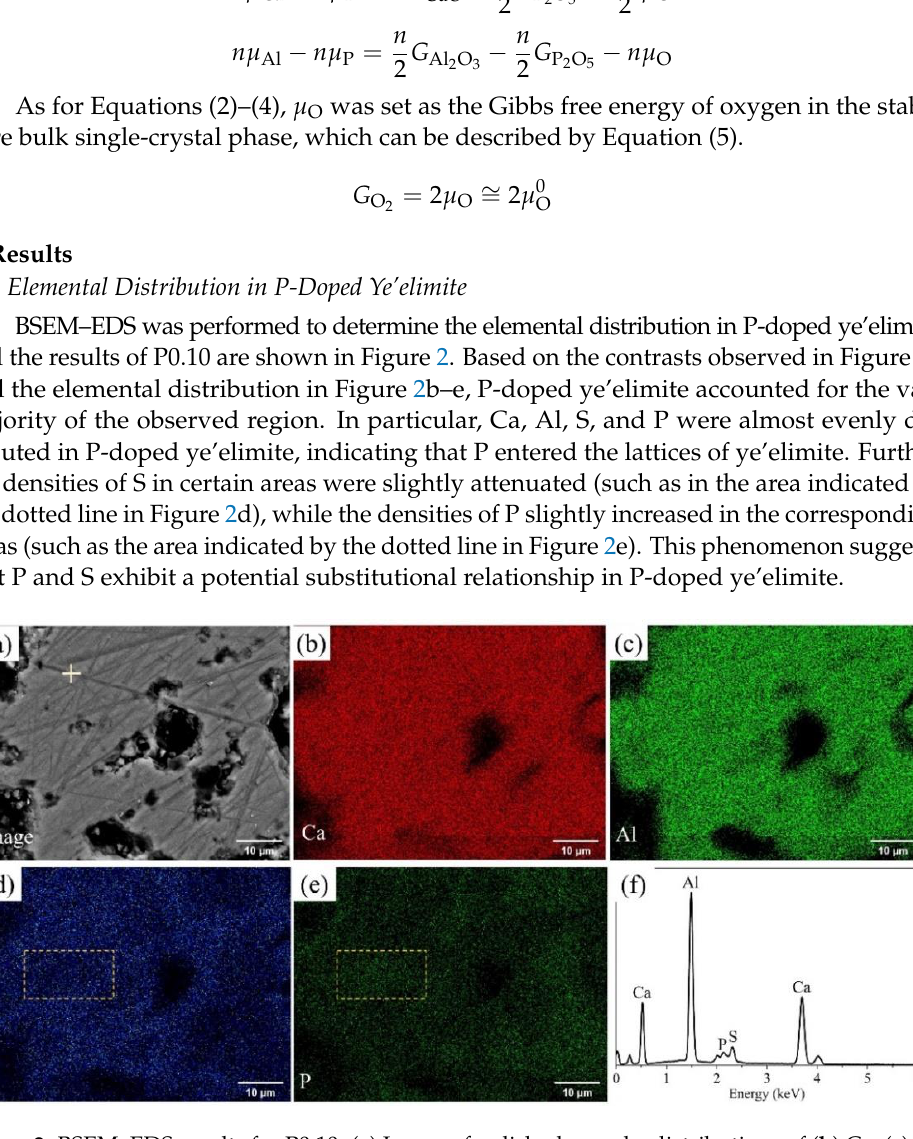
Figure 2. BSEM – EDS results for P0.10: ( a ) Image of polished sample, distributions of ( b ) Ca, ( c ) Al, ( d ) S, and ( e ) P, and ( f ) EDS result for the crossed point in Figure 2a.